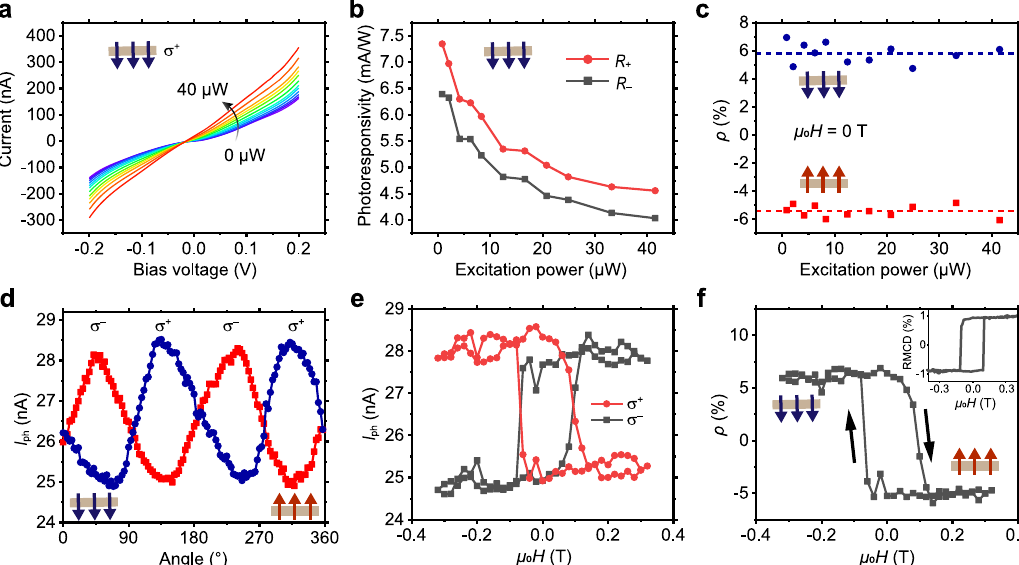
Fig. 2 The magneto-optoelectronic response in the monolayer CrI 3 device D1. a I – V curves of the device with a down magnetized state under σ þ excitation with various powers (from 0 to 40 μ W) measured at μ 0 H = 0 T (increased from − 0.3 T). For identical bias, the light-on current ( I light ) increases monotonically with the excitation power. b Excitation power-dependent photoresponsivities ( R + and R − ) measured at V = 0.2 V under σ þ (red) and σ (cid:2) (black) excitations in the down magnetized state CrI 3 . c Excitation power dependent photoresponsivity polarization ρ measured at μ 0 H = 0 T. The ρ is independent of excitation power with average values of ~ − 6% (red dashed line) for the up state (red dots) and ~ + 6% (blue dashed line) for the down state (blue dots). d Photocurrents, measured at V = 0.15 V, versus the angle of the quarter-wave plate. The up (down) state CrI 3 exhibits a higher σ (cid:2) ( σ þ ) photocurrent. e Circularly excited photocurrents under various magnetic fi elds. The red (black) color denotes the σ þ ( σ (cid:2) ) excitation result. When μ 0 H sweeps between ±0.3 T, the photocurrent behaviors are opposite for σ þ and σ (cid:2) excitation. f The photoresponsivity polarization ρ values and the re fl ective magnetic circular dichroism (RMCD) signals (the inset) at various μ 0 H . When μ 0 H sweeps between − 0.3 and + 0.3 T, ρ changes between 6 and − 6%, and RMCD signal changes between − 1 and + 1%. The CrI 3 spin- fl ip transitions occur at ±0.1 ρ increases from 0% to a saturation value of 6% (black dots). By ð 1 (cid:2) T Þ β (red line), where ρ curve fi tting the data with ρ T ð Þ ¼ ρ T c 0 0 is the critical amplitude, β is the critical exponent, we obtain = 40 K, close to the Curie temperature of monolayer CrI T c 3 (45 K).